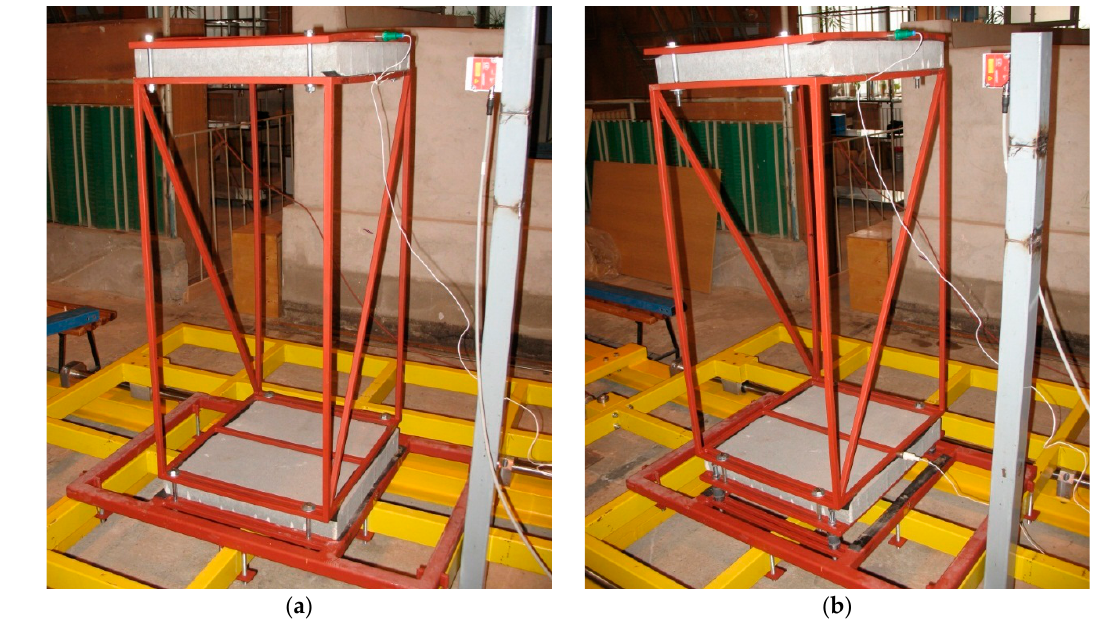
Figure 7. Fixed-base ( a ) and base-isolated ( b ) single-storey structure model.